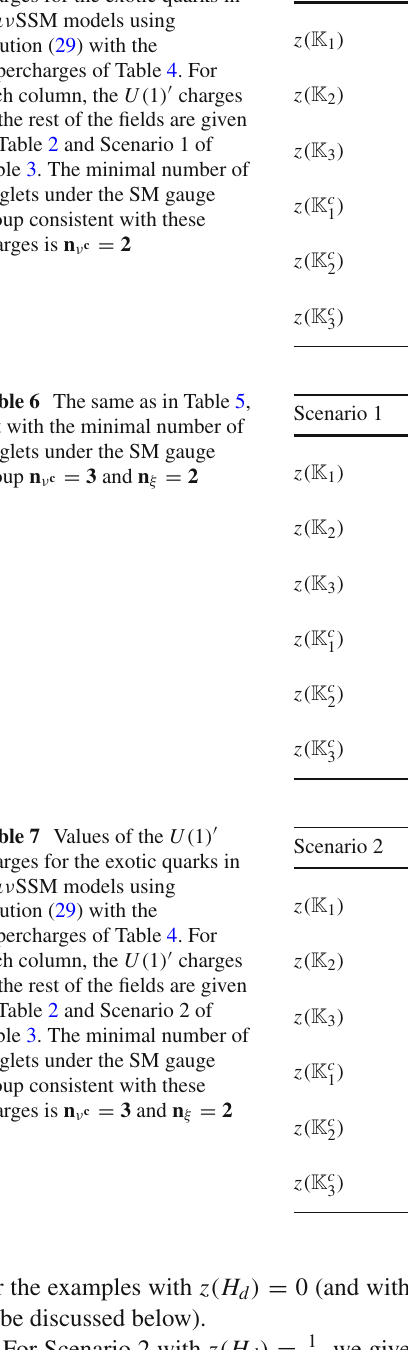
Table 5 Values of the U ( 1 ) (cid:2) charges for the exotic quarks in U μν SSM models using solution (29) with the hypercharges of Table 4. For each column, the U ( 1 ) (cid:2) charges of the rest of the fields are given in Table 2 and Scenario 1 of Table 3. The minimal number of singlets under the SM gauge group consistent with these charges is n ν c = 2